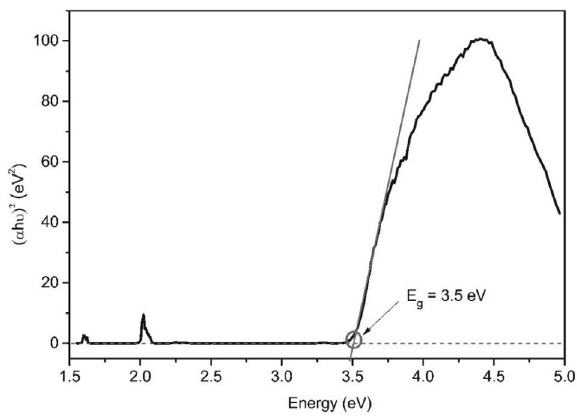
Fig. 7. Optical band gap of NdVO 4 nanoparticles.